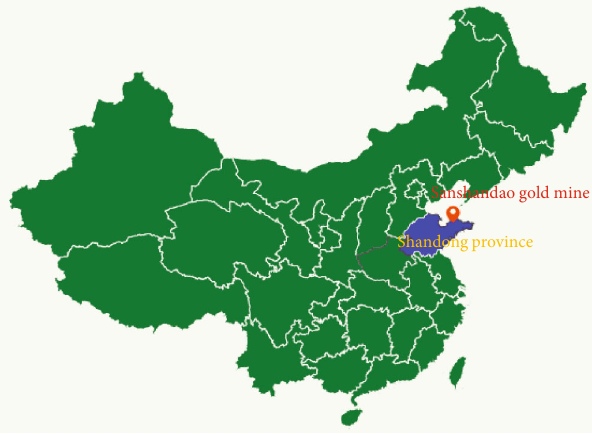
Figure 1: Location of Sanshandao gold